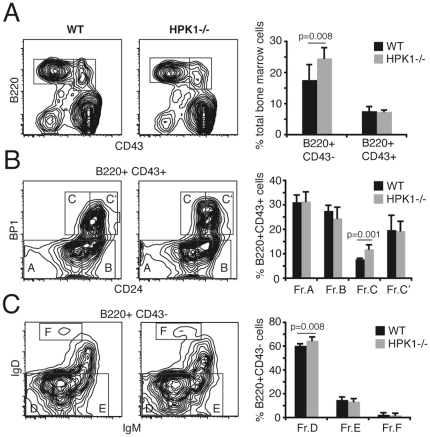
Bone marrow B-cell development of HPK1−/− mice.(A) Total bone marrow of 7 weeks old WT and HPK1−/− mice stained with CD43/B220 to delineate early and late B-cell fractions; cells were further stained with (B) BP1/CD24 for pro-pre B-cells stages or (C) IgM/IgD for immature/transitional fractions; right: graphs are representative for 5 independent experiments and results are presented as means ± SD (Student's t).